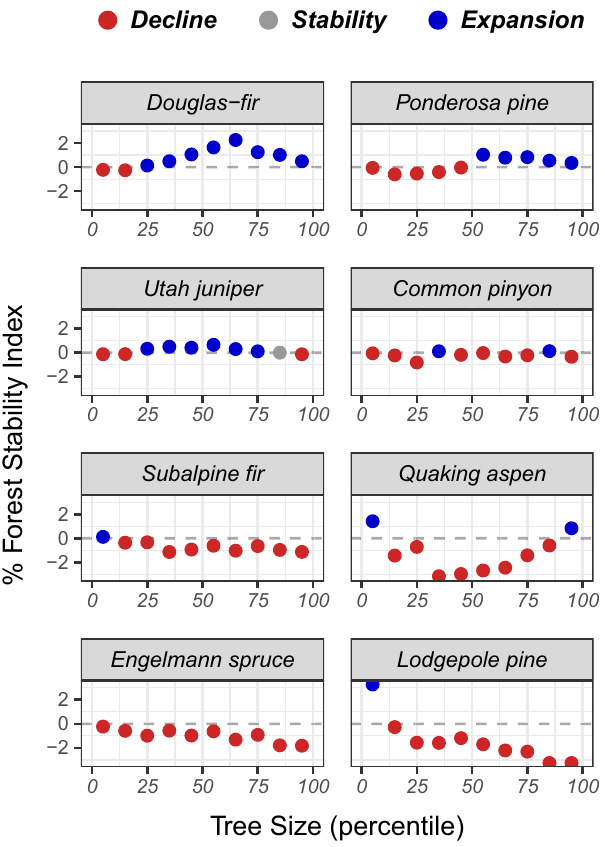
Fig. 3 Range-average % forest stability index (FSI) across size distributions of the eight most abundant tree species in the western US over the period 2001 – 2018. Population decline (red) occurs when the FSI is negative and the associated con fi dence interval does not include zero. Conversely, population expansion (blue) occurs when the FSI is positive and the associated con fi dence interval does not include zero. Here, the %FSI is a direct measure of average annual percent change in the relative density of each species across their ranges in the western US, and variation in the FSI across species-size distributions is indicative of shifts in forest structure during the study period. Total % change in relative density can be estimated by multiplying the %FSI by the length of the study period (18 years), with a maximum annual decline of − 5.56% (complete loss of the population over the study period). Source data are provided as a Source Data fi